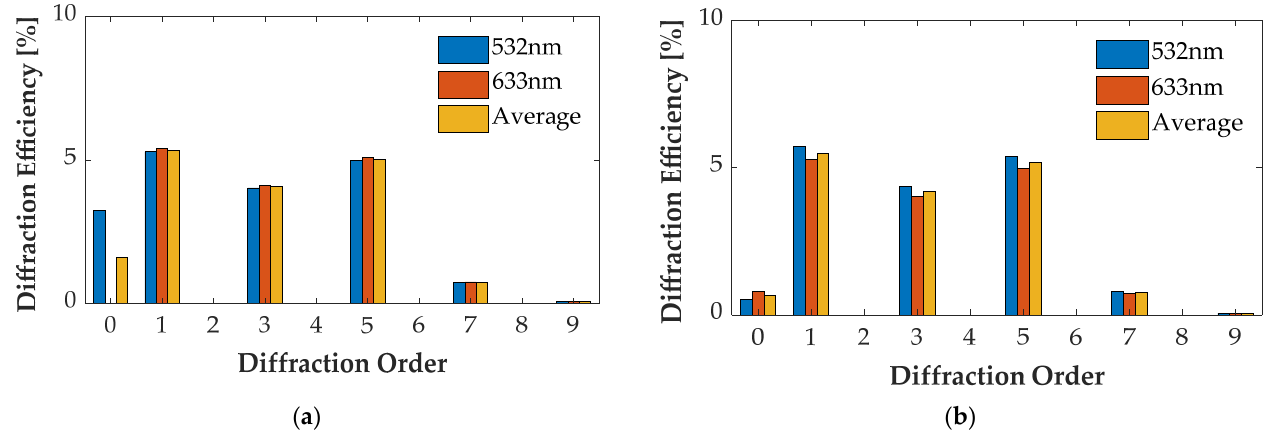
Figure 22. Diffraction efficiency of AH53_opt. ( a ) AH53_opt with the groove depth of 158.25 nm; ( b ) AH53_opt with the groove depth of 143 nm.